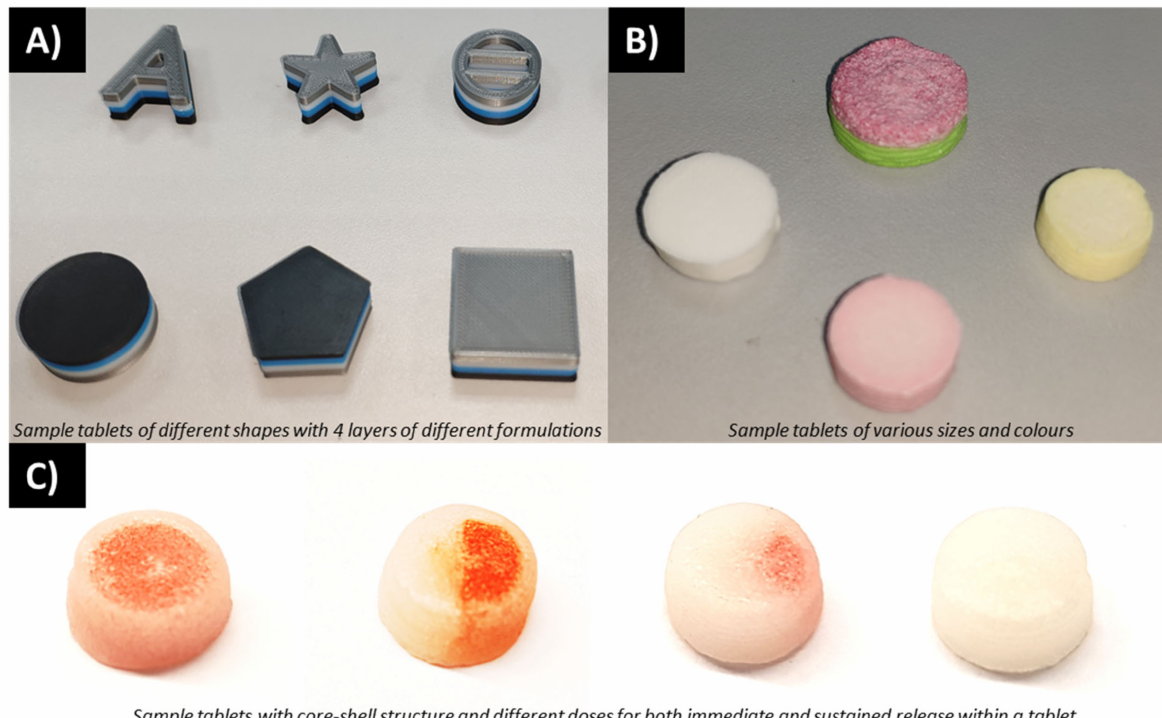
Figure A1. Image of various 3D printed tablets. (Credit: Craft Health Pte. Ltd.,